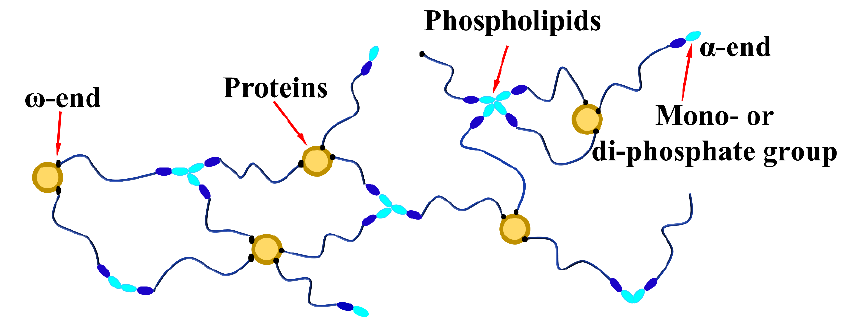
Figure 1. Molecular chain structure of NR